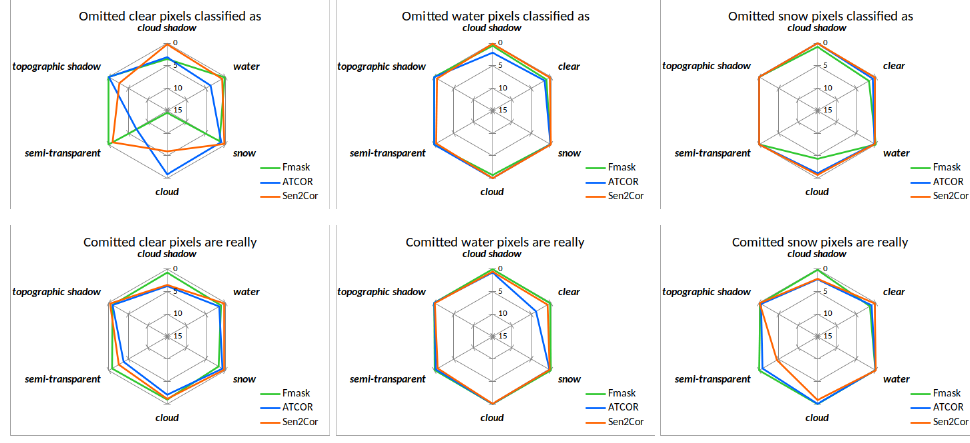
Figure 11. Omission and commission per Class for difference area for clear classes clear land, water and snow.